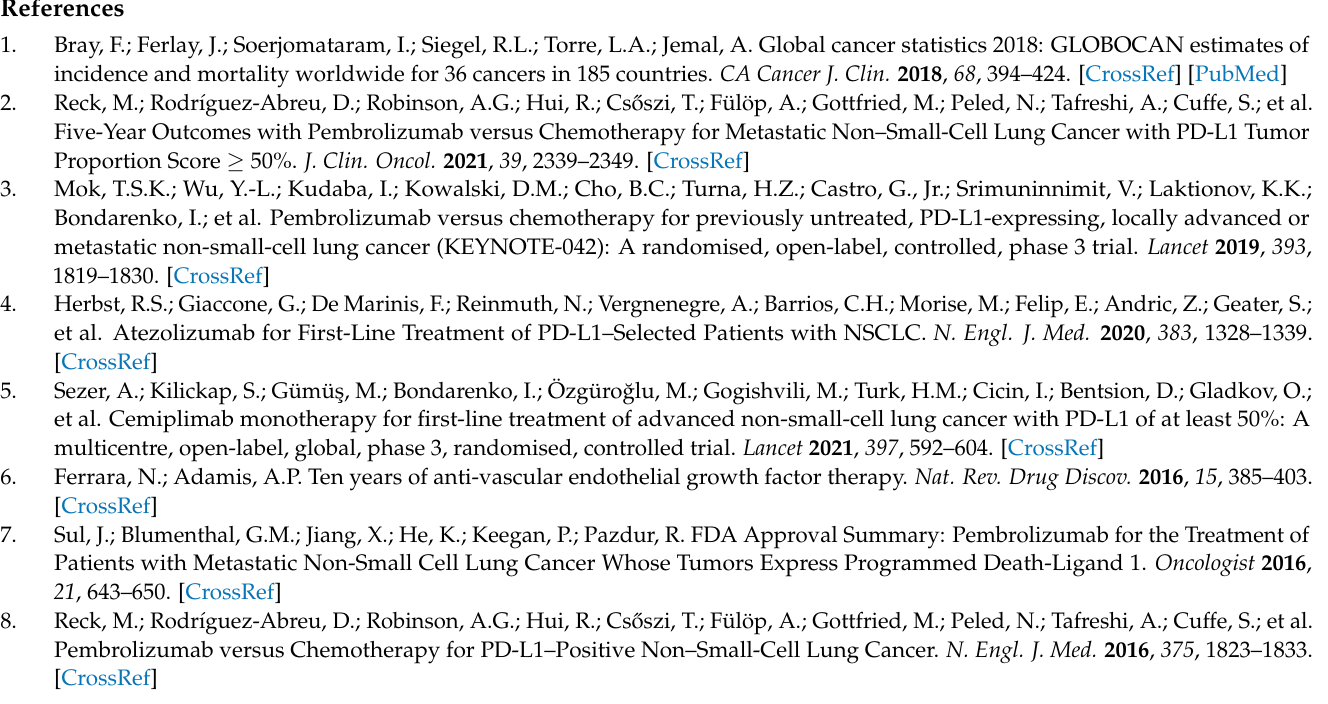
to Cochrane Collaboration’s tool. Figure S2: Forest plot of hazard ratios (HRs) for OS in NMA. Figure S3: Forest plot of hazard ratios (HRs) for PFS in NMA. Figure S4: Forest plot of risk ratios (RRs) for ORR in NMA. Figure S5: Forest plot of risk ratios (RRs) for ≥ 3 TRAEs in NMA. Table S1: Search Strategy. Table S2: Rank probabilities with SUCRA value for different outcomes in 6 kinds of first-line treatments for patients with non-squamous NSCLC. Table S3: Rank probabilities with SUCRA value for different outcomes in 6 kinds of first-line treatments for subgroup patients with non-squamous